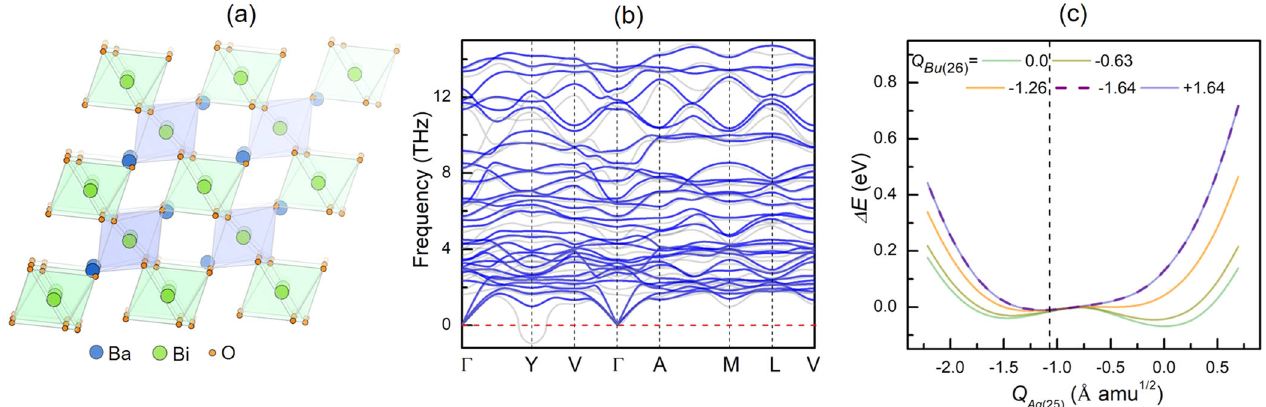
Fig. 2 Phonon spectrums of monoclinic BaBiO 3 and energy pro fi les of the coupled phonons. a Crystal structure of the supercell used for phonon calculations. b Phonon spectrums of monoclinic BaBiO 3 at 0 K (gray lines) and 300 K (blue lines). c Calculated total energy as a function of the A g (25) amplitudes for several values of the B u (26) mode amplitudes. We plot Δ E ¼ E ð Q R ; Q IR Þ (cid:2) E ð(cid:2) 0 : 82 ; Q IR Þ for visual purposes. The vertical dash line denotes the minimum of the single-well